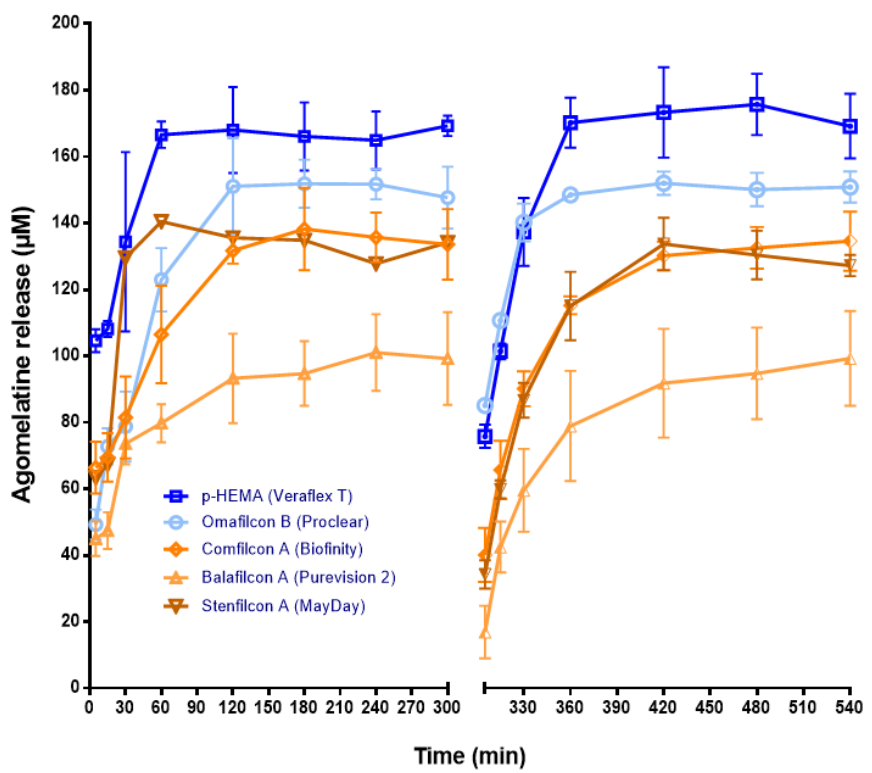
Figure 3. The agomelatine release from CLs previously soaked with agomelatine solution (1 mL, 1 mM) for 12 h to a saline solution (1 mL) over 540 min, with a change in the saline medium at 300 min. Concentration ( µ M) values are presented as mean ± S.D of n = 9 lenses per material. The blue color shows the release from CH CLs. The ochre color shows the release from SH